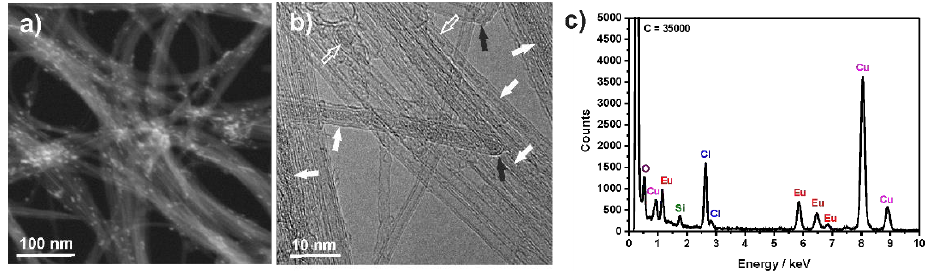
Figure 4. Electron microscopy imaging and energy-dispersive X-ray (EDX) spectroscopy of EuCl 3 @CNTs filled at 1100 °C. ( a ) High-angle annular dark-field scanning transmission electron microscopy (HAADF-STEM) image, ( b ) High resolution transmission electron microscopy (HRTEM) image (as a guide to the eye, white arrows point to CNTs filled with nanowires of EuCl 3 , empty white arrows to filling with nanoparticles, and black arrows point to closed ends) and ( c ) EDX spectrum of the sample, confirming the presence of Eu and Cl (the carbon peak maxima was cut down for better visibility of lower intensity peaks).